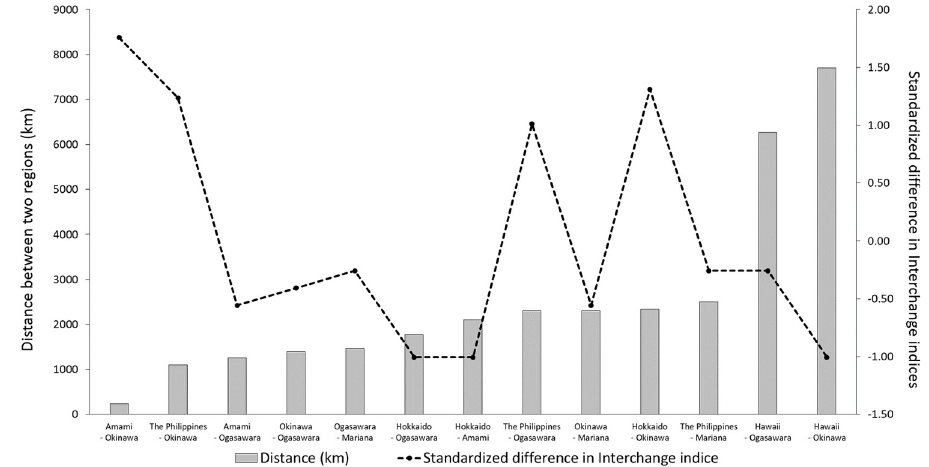
Fig 3. Distance (km) and standardized difference in interchange indices between sighting areas of humpback whales in the western North Pacific. The bar chart and left axis indicate the distance between two sighting areas, when the line chart and right axis indicate the standardized difference in interchange indices between two sighing areas.